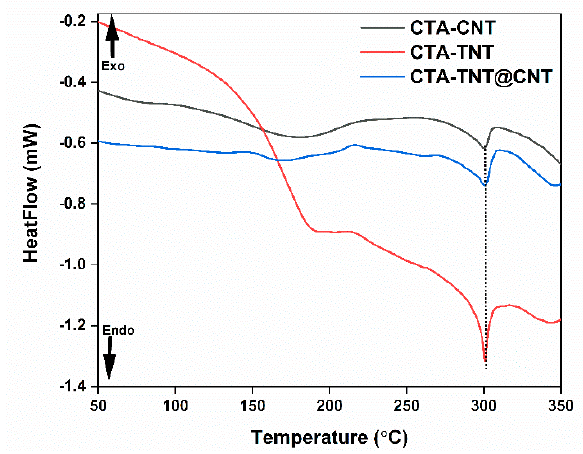
Figure 5. DSC thermograms of the synthesized CTA-TNT@CNT MMMs.